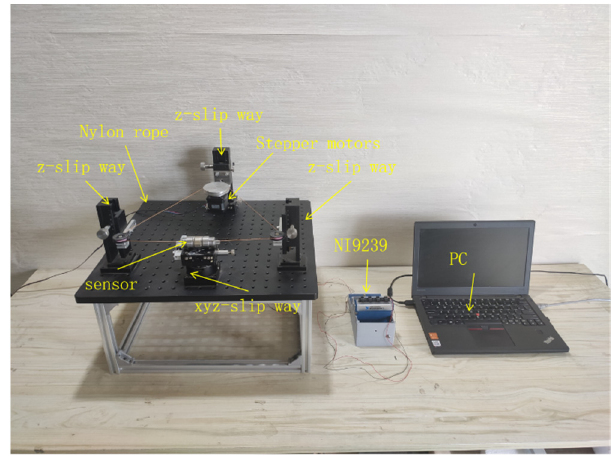
Figure 11. Single wear debris motion experimental rig.